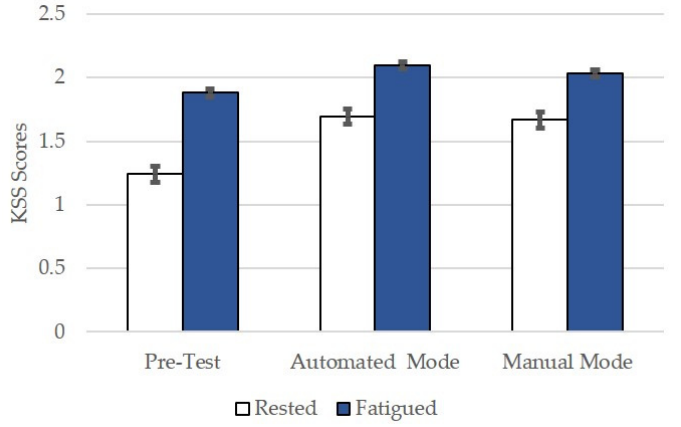
Figure 4. Subjective fatigue scores in different conditions and driving modes. Error bars indicate SD.